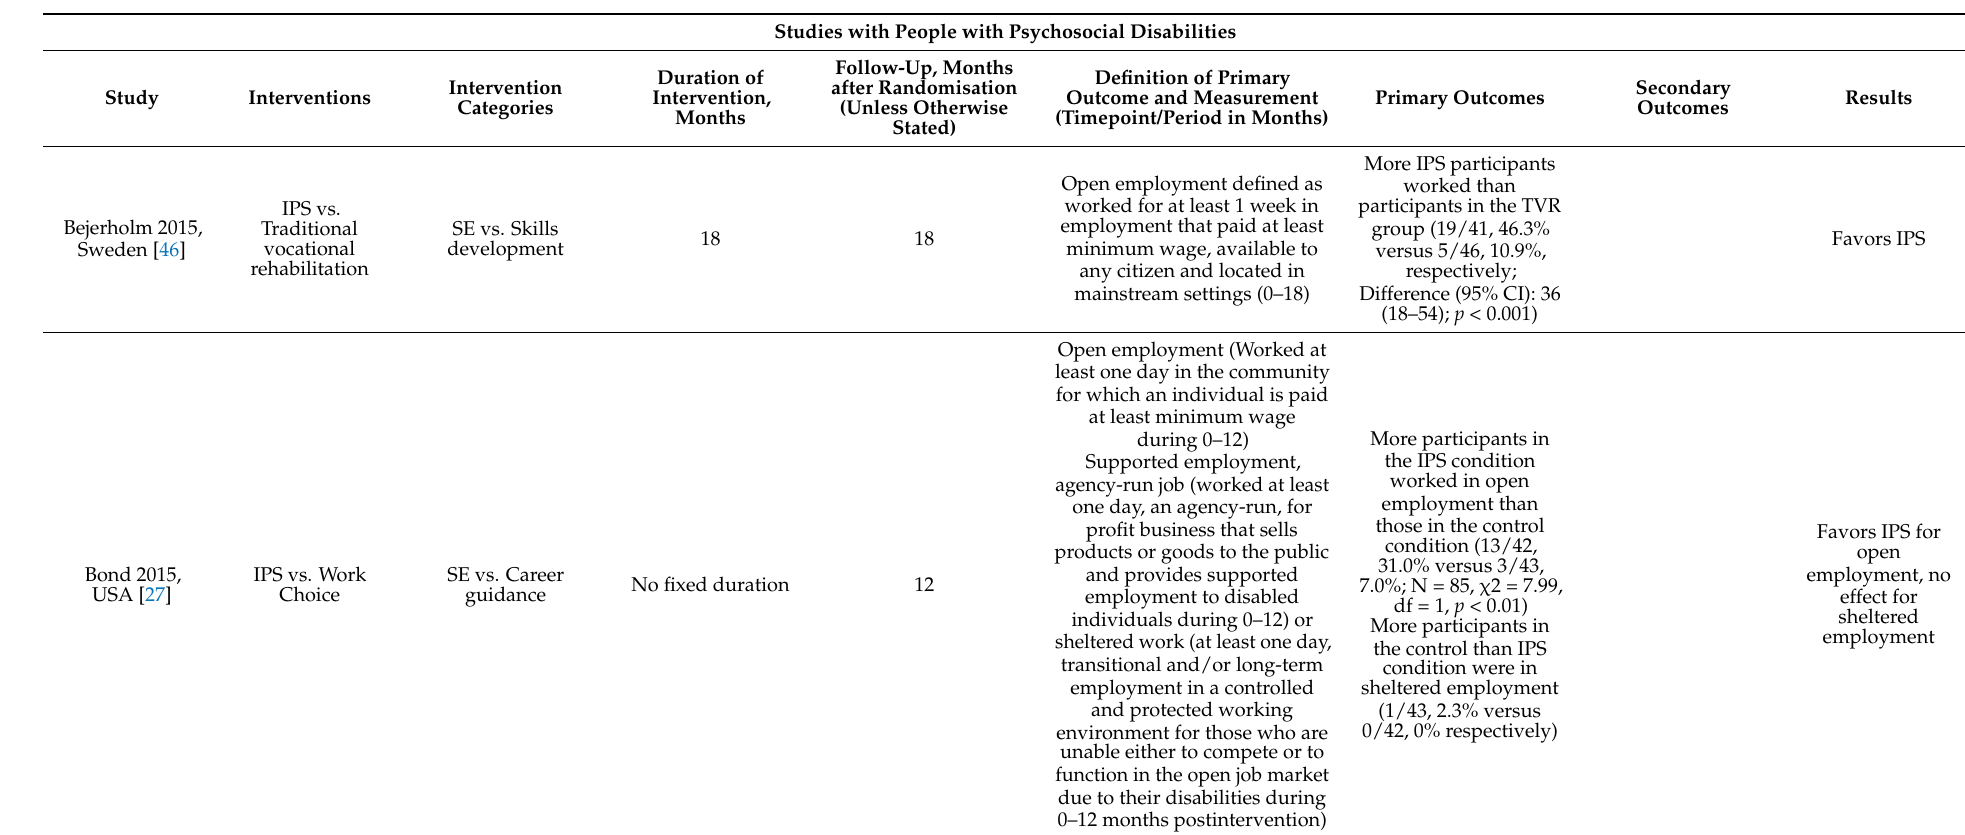
Table 2. Interventions and outcomes of included